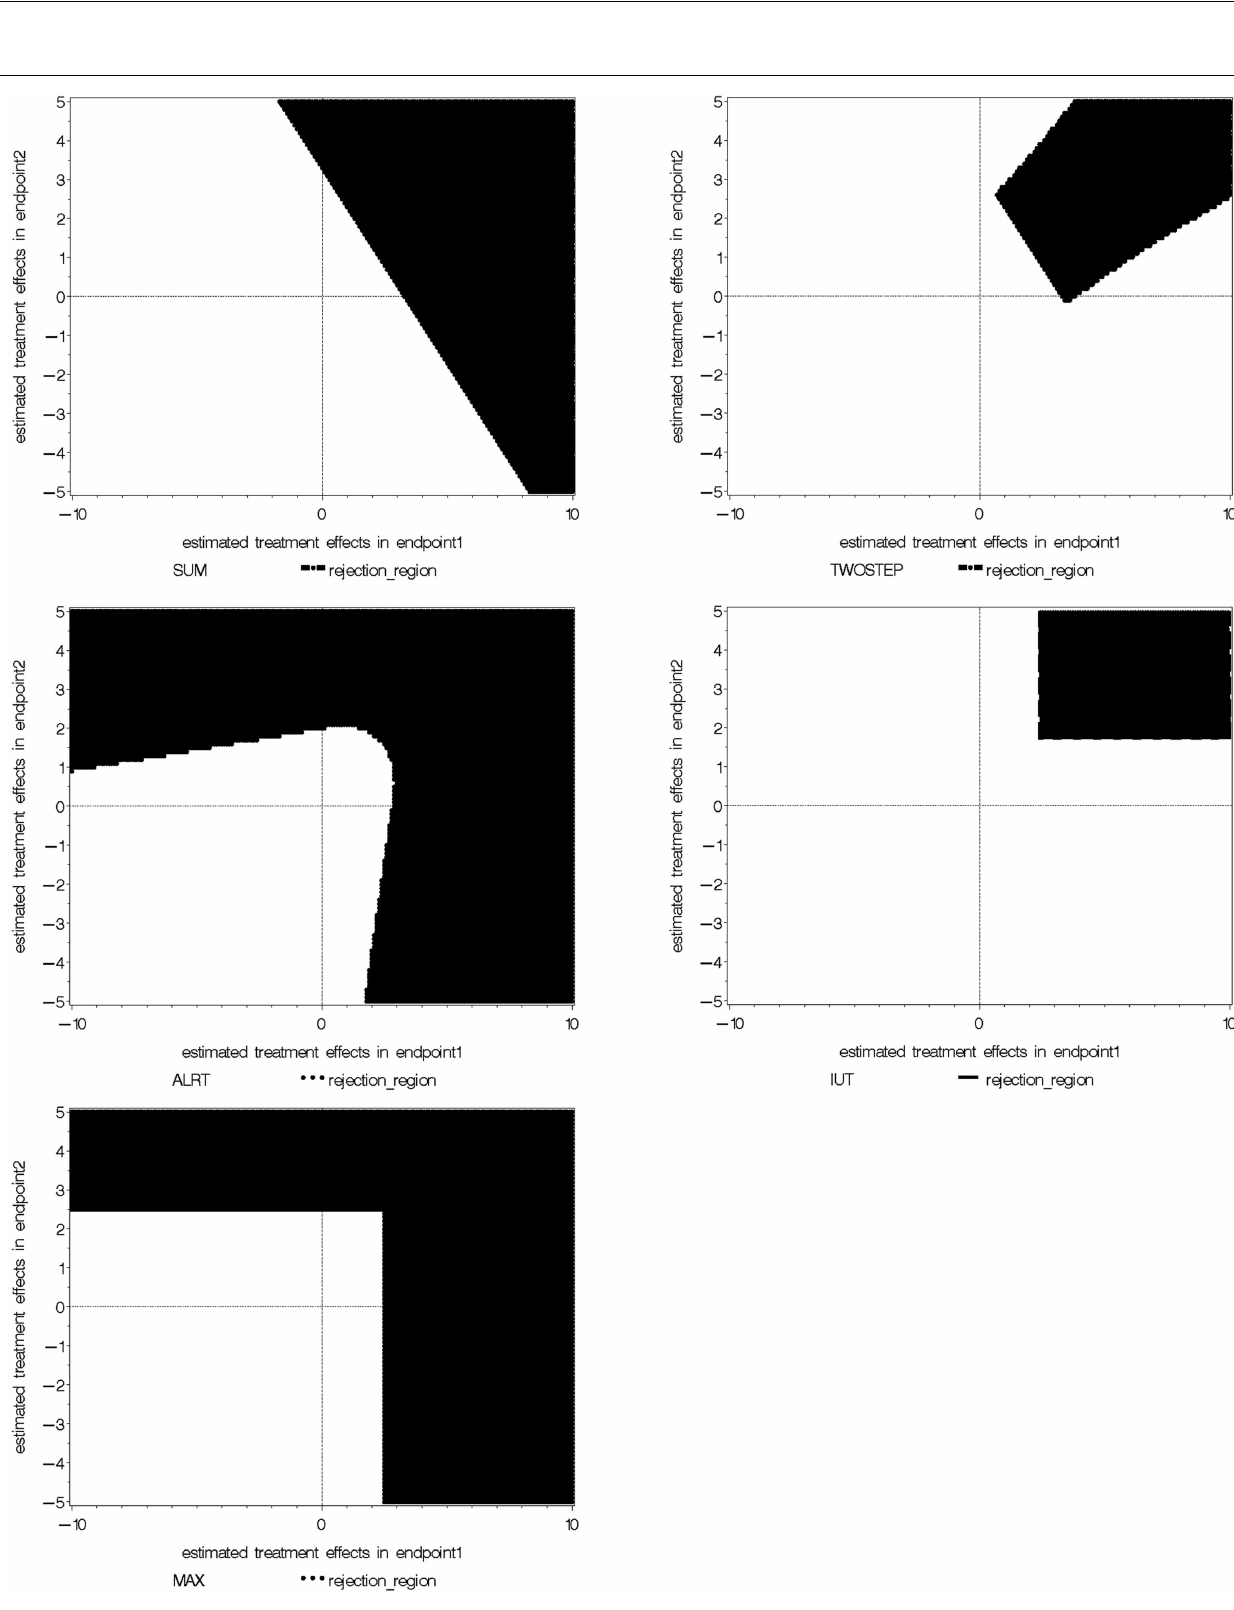
FIGURE 1 | Comparison of rejection regions of five global tests